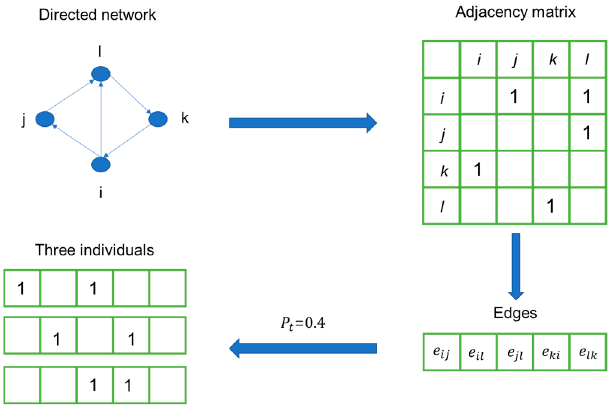
Figure 2. An illustration of the initialization process.